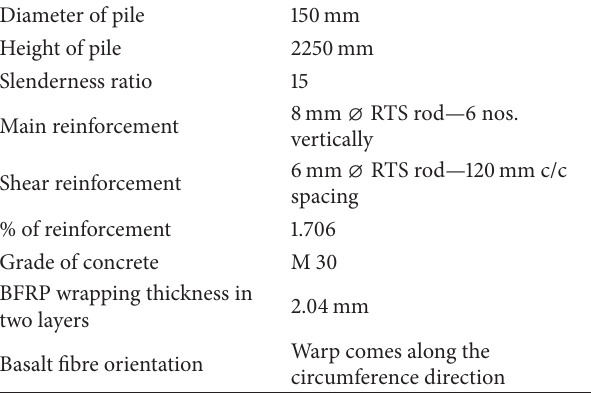
Table 9: Properties of RCC end bearing